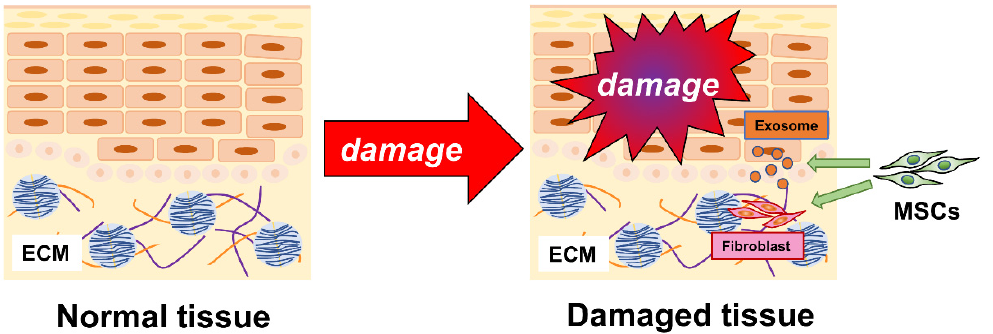
Figure 1. Mesenchymal stem cells promote cutaneous wound healing.